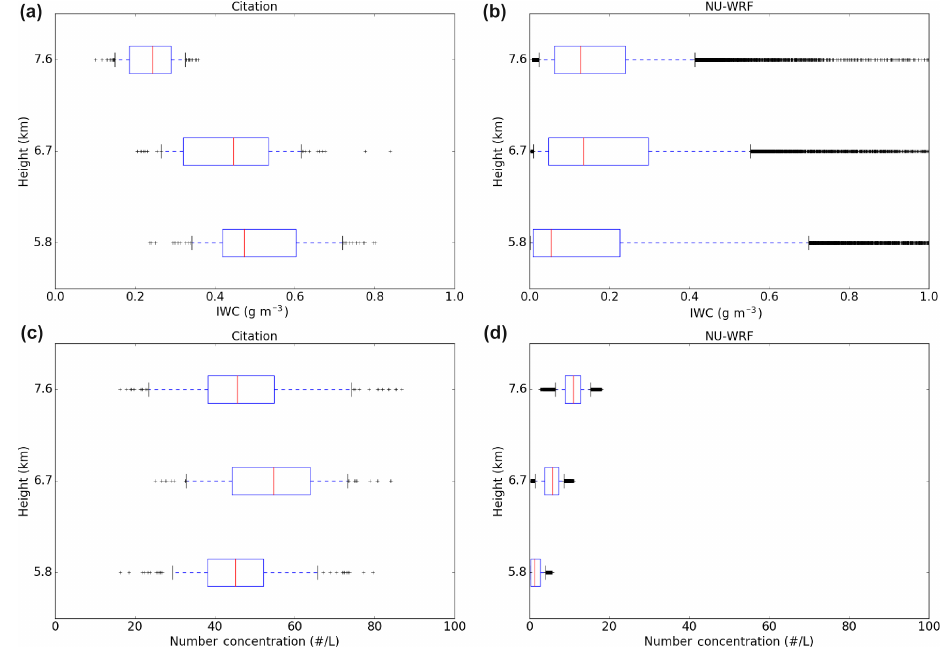
Figure 10. Total ice water content (IWC; a , b ) and ice number concentration ( N i ; c , d ) derived from aircraft observations ( a , c ; see text) and from the BASE simulation (b, d) within the respective red-bounded geographic regions shown in Fig. 9. Simulated ice is the sum of all ice classes. Observed ice is the sum of all size bins shown in Fig. 11. Box and whisker symbols represent the median, inner half, and 5th and 95th